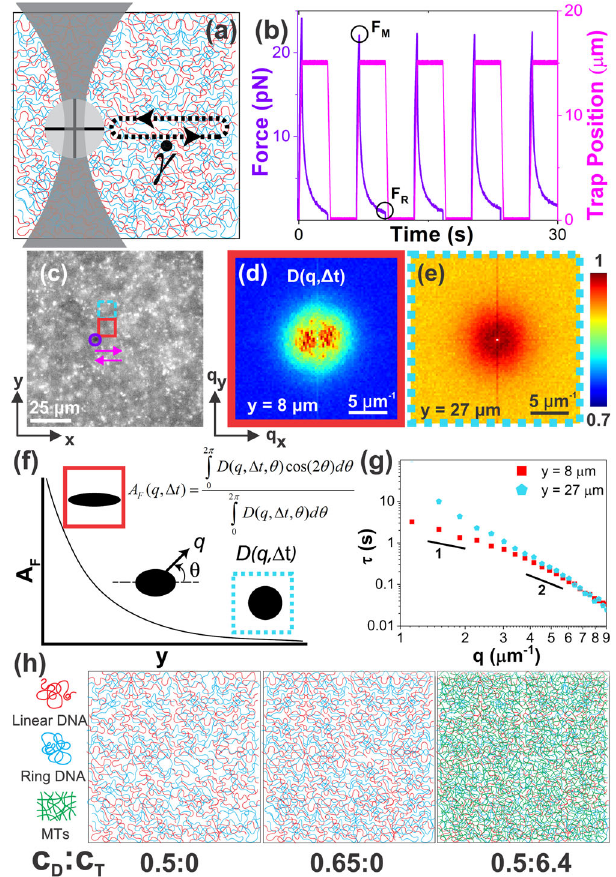
Fig. 1 | OpTiDDM couples stress response to macromolecular dynamics and their propagation. a , b Optical tweezers (OpT): a A microsphere probe (gray circle)embedded in apolymernetworkis trapped using a focused laser beam,and cyclically swept through a distance s =15 μ m at strain rates of _ γ = 9.4 − 189s − 1 for 50s, including Δ t R = 3s cessation periods between each sweep. b We measure the trap position (magenta) and force exerted on the probe (purple), and evaluate the maximumforcereachedduringeachsweep F M andtheresidualforceattheendof eachcessationperiod F R . c Duringeachstrain,wecollecttime-seriesof fl uorescent- labeled DNA molecules in the networks. The purple circle and magenta arrows indicate the probe position and direction of motion. We divide the FOV into (16.6 μ m) 2 ROIs centered horizontally with the strain path at 10 vertical distances centered at y = ±8 μ m (red border shows +8 μ m) to y = ±27 μ m (blue-dashed border shows +27 μ m) above (+) and below ( − ) the strain path, and determine the corresponding DDM image structure function D ð q , Δ t Þ . d , e D ð q x , q y Þ plots at a lag time Δ t =0 : 25 s for boxed-in ROIsshow that d nearthe strain( y = 8 μ m), D ð q , Δ t Þ is anisotropic with two lobes that lie along the strain axis, while e far from the strain ( y = 27 μ m), D ð q , Δ t Þ is radially symmetric. Colorscale indicates the magnitude of D ð q , Δ t Þ ,normalizedbythecorrespondingmaximum D ð q , Δ t Þ value. f Thealignment factor, A F ( y ), schematically portrayed and computed using the equation shown, quanti fi es the preferential alignment of D ð q , Δ t Þ with the strain path, generally decreasing with increasing y as qualitatively depicted. g DDM decay times τ ð q Þ determined by fi tting D ð q , Δ t Þ describe the macromolecular dynamics, with diffu- sive and ballistic dynamics described by τ q ð Þ ~ q (cid:2) 2 and τ q ð Þ ~ q (cid:2) 1 respectively. h Cartoons of the polymer networks we investigate, de fi ned by the mass con- centration (mg/ml) of the ring-linear DNA blend c D (0.5 or 0.65) and molar con- centration( μ M)oftubulindimers c T (0or6.4)(seeFigS1).Datashownin b – g isfor the 0.5:0 system subject to a strain rate of _ γ = 42s − 1